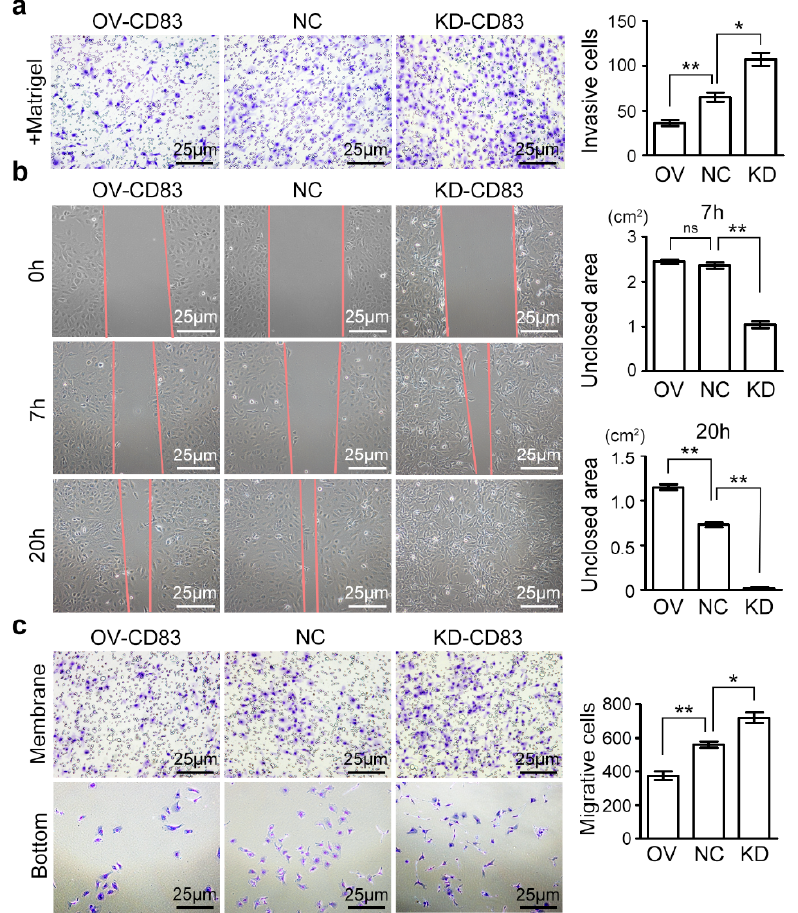
Figure 3. CD83 inhibited the invasion and migration of ovarian cancer cells. ( a ) Representative images and quantification of invasive SKOV3 cells in OV-CD83, NC, and KD-CD83 transwells using matrigel invasion assay. Scale bar, 25 µ m. ( b ) The migration ability of SKOV3 cells was determined by wound-healing assay, and the closed wound area was calculated at 0, 7, and 20 h. ( c ) Representative images and quantification of migrative cells using a transwell migration assay. Scale bar, 25 µ m. The di ff erences between NC and OV, as well as NC and KD, were presented as the mean ± SEM; Student’s t -test; * p < 0.05, ** p < 0.01, ‘ns’ means not significant.